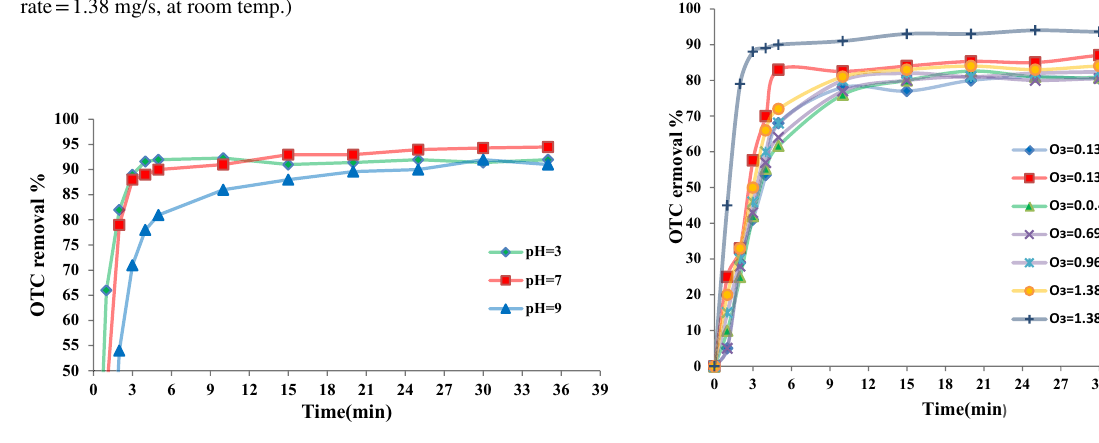
Fig. 9 Effect Of Ozonation Rate On OTC Removal Efficiency (pH = 7, OTC conc. = 50 mg/l, at room